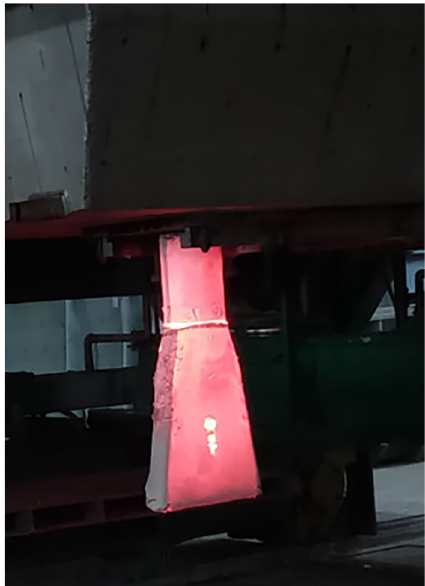
Figure 16: NSEN for experiment.